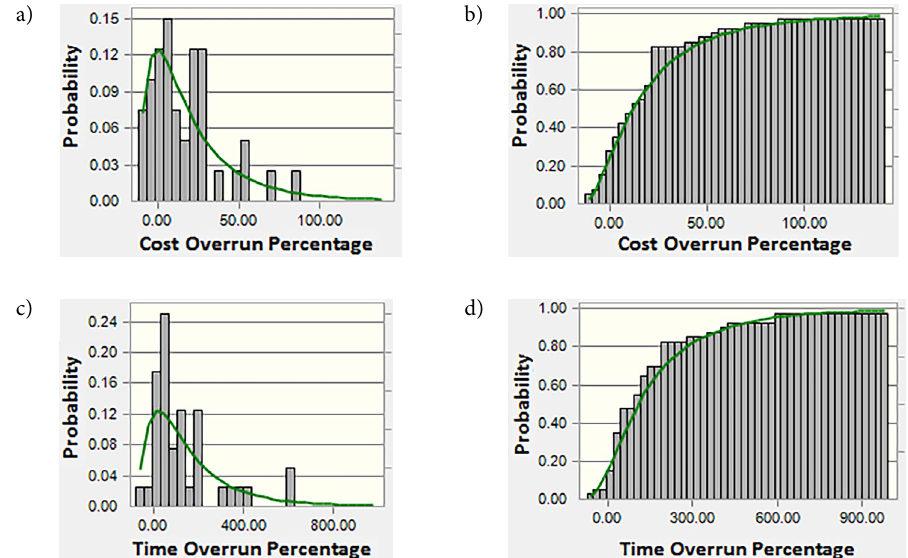
Figure 7. The best fit PDF and CDF for cost and schedule overrun: a – Best fit PDF for cost overrun, lognormal with m = 21.99, s = 34.97 and g = 17.33; b – CDF for cost overrun; c – Best fit PDF for schedule overrun, lognormal with m = 166.29, s = 217.5 and g = 104.9; d – CDF for schedule overrun